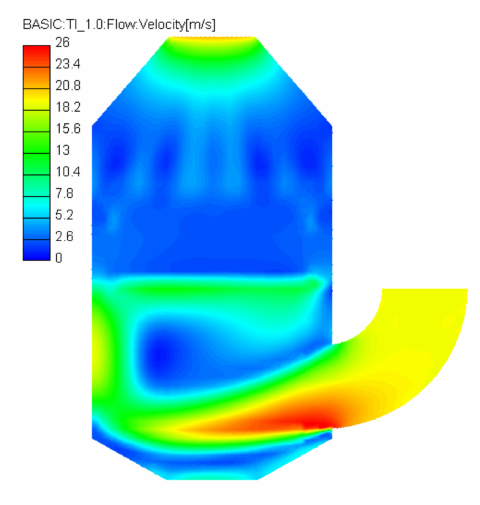
Figure 5. Velocity map inside the scrubber.